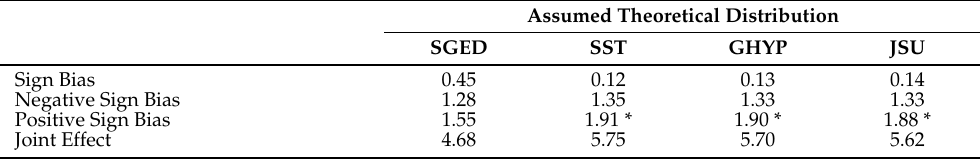
Table 4. Test values of the sign bias test for standardized residuals ˆ ν t